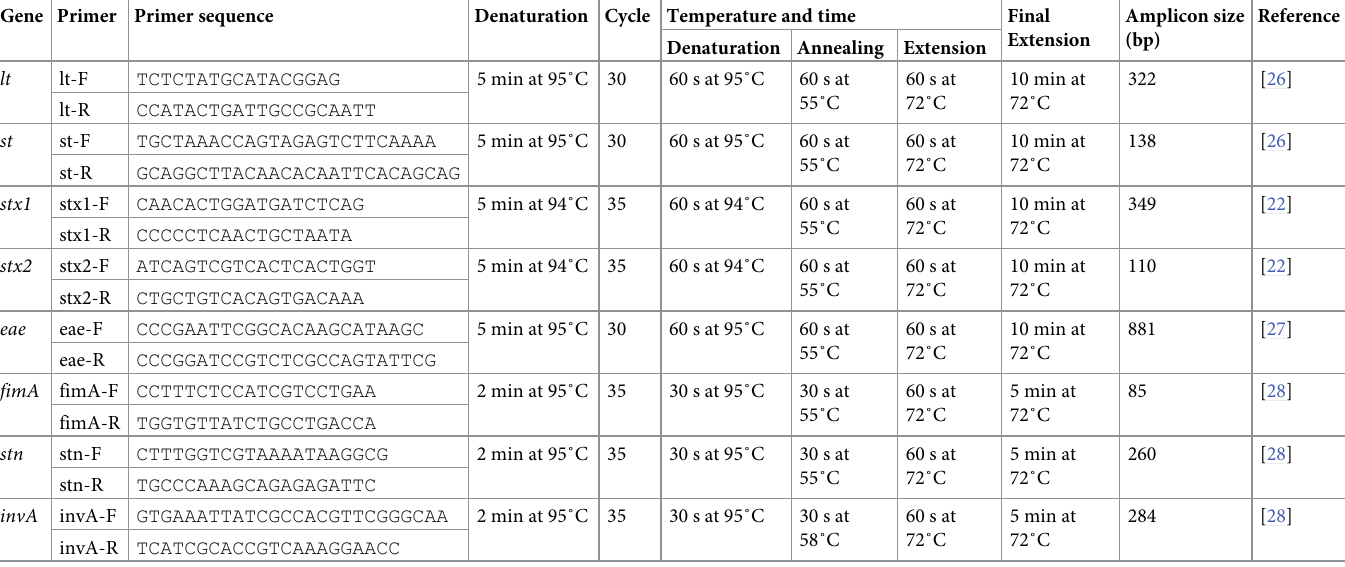
Table 3. Primer used and PCR condition for virulence gene in E . coli and Salmonella isolates. Gene Primer Primer